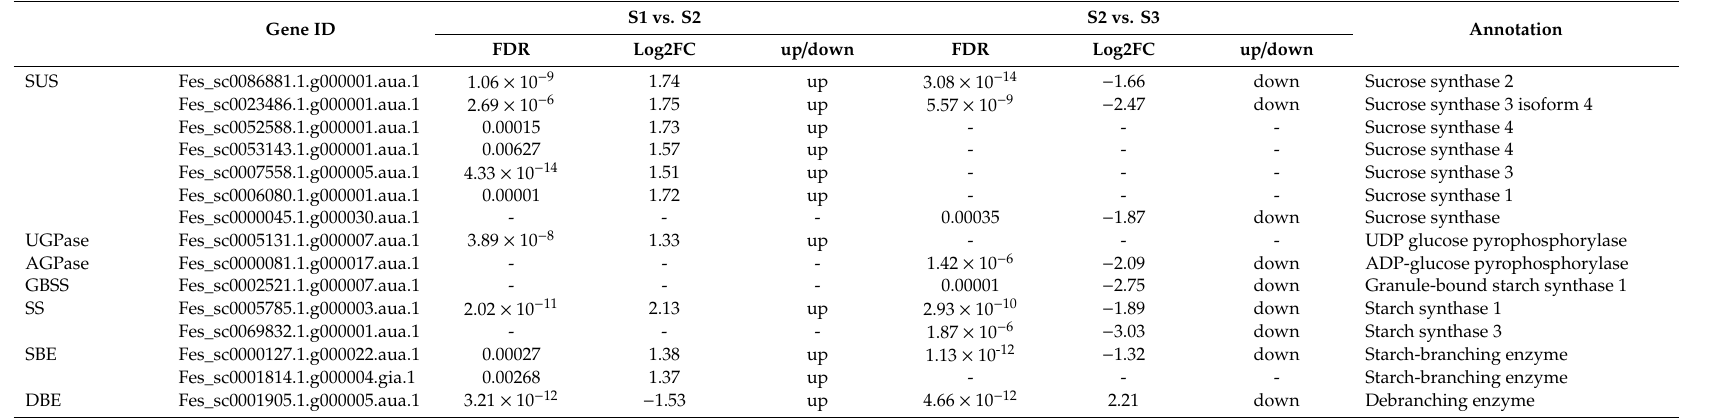
Table 4. DEGs involved in starch biosynthesis. S1, S2, and S3 stand for the seed samples at pre-filling stage, filling stage, and initial maturity stage, respectively. FDR stands for false discovery rate. Log2FC stand for Log2 fold